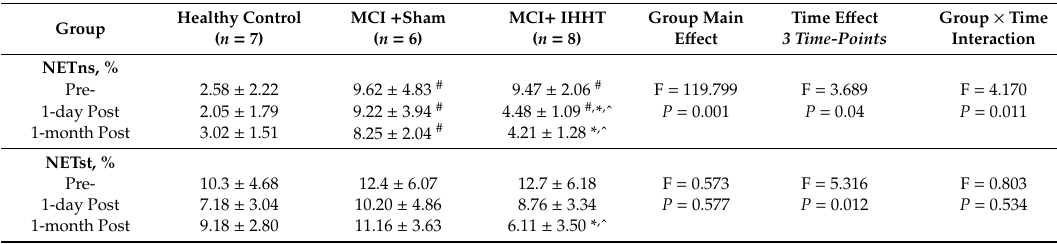
Data are mean ± SD and analyzed with two-way ANOVA with repeated measures. Abbreviations: